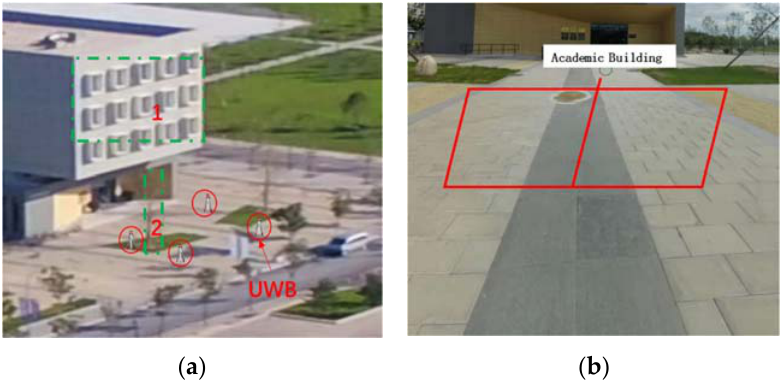
Figure 4. Experimental scene of the BDS/GPS/UWB tight combination positioning. ( a ) Overall overview of the experimental scene. ( b ) Walking path.